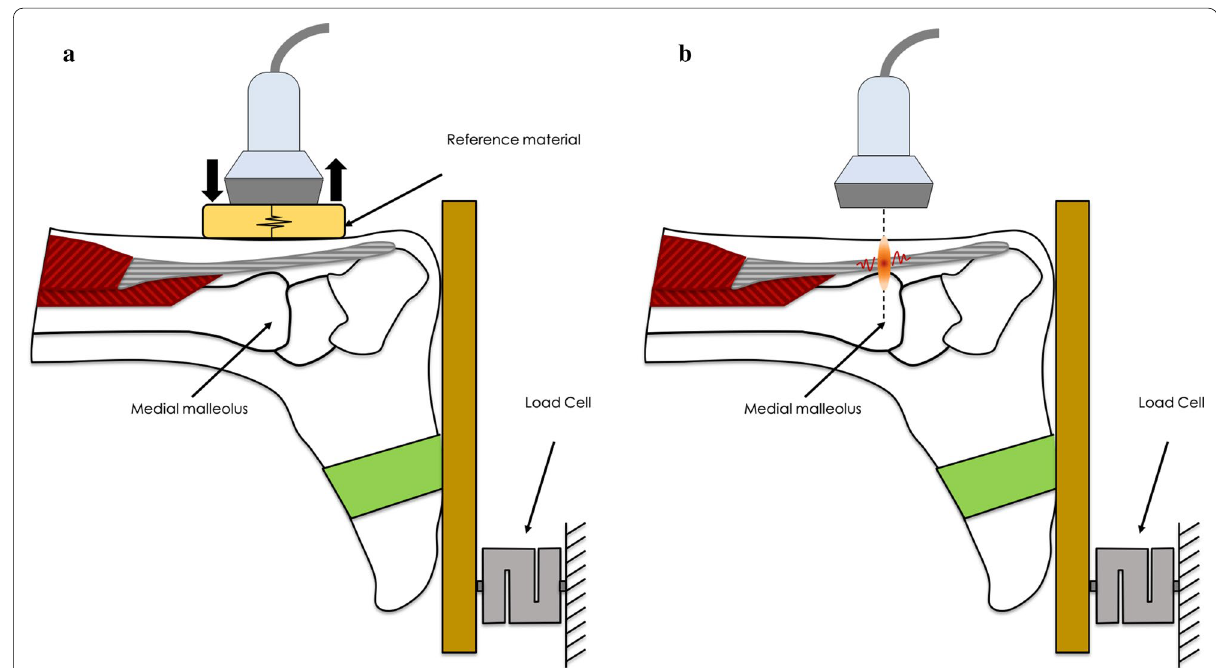
Fig. 1 Schematic of the experimental setup. a Strain sonoelastography with reference material b Shear Wave sonoelastography. Ultrasound probe was placed in a longitudinal scan at the level of the medial